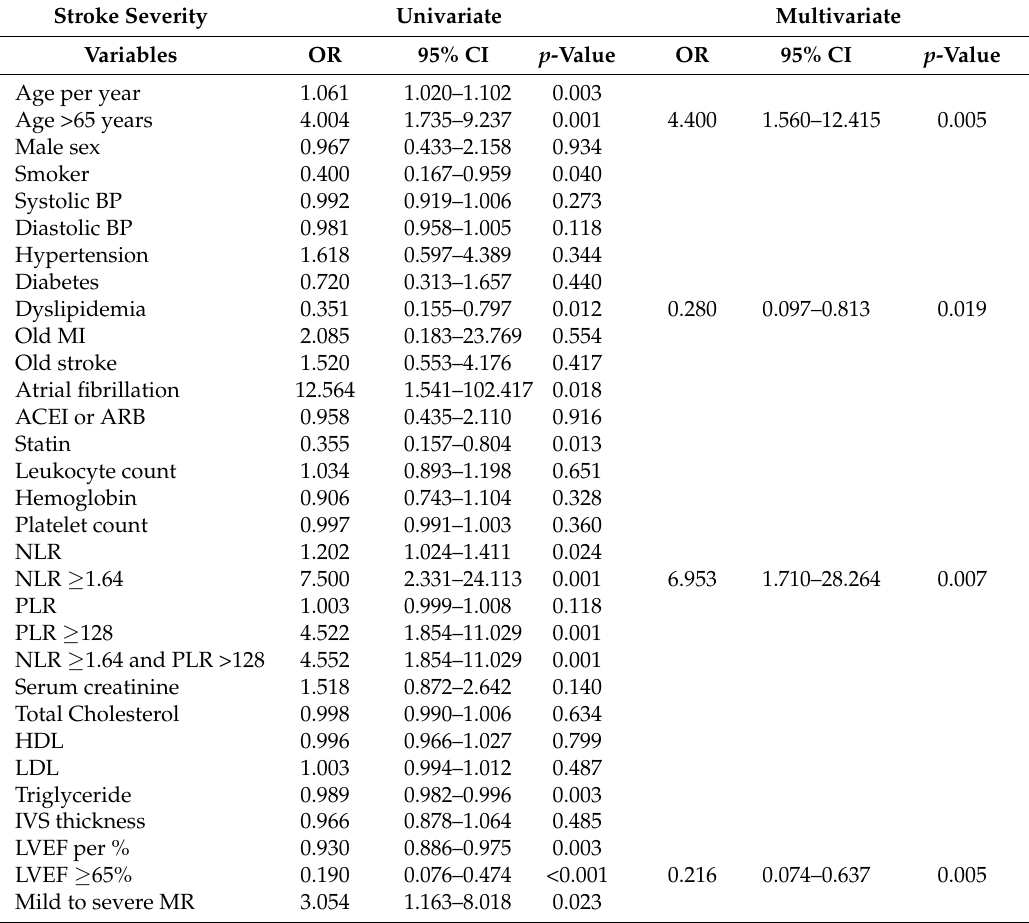
Table 4. Predictors for stroke severity with NIHSS ≥